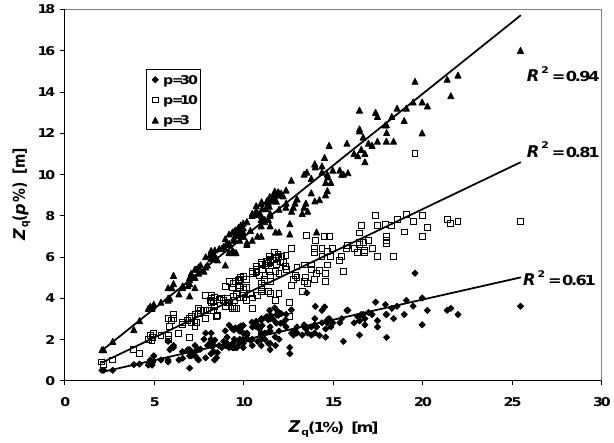
Fig. 9. The depth of the p % levels Z q (p %) of the surface quanta irradiance, as a function of Z q (1%) for p equal to 3, 10 and 30. The best-fit lines through the origin are Z q (3%) = 0.69 Z q (1%), Z q (10%) = 0.41 Z q (1%), and Z q (30%) = 0.20 Z q (1%).